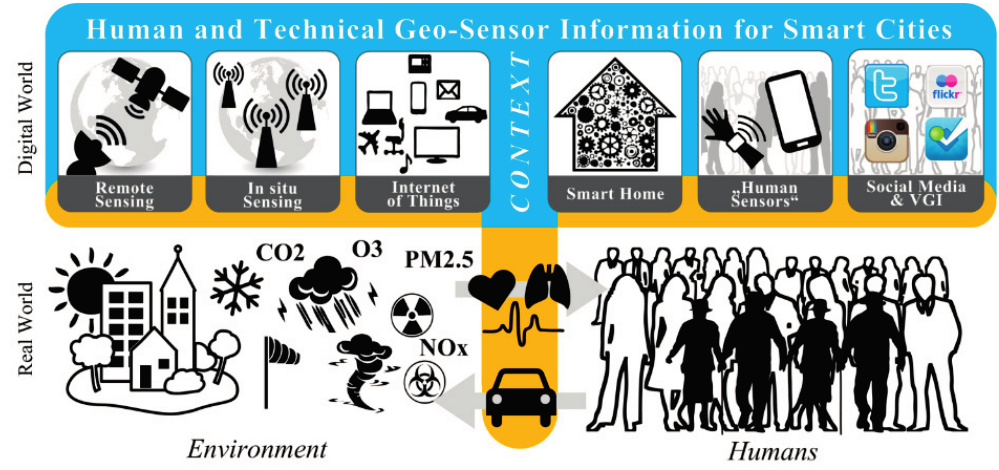
Figure 3. Technology-enabled contextual sensing for smart cities: context-enriched human and technical geo-sensor information for smart cities (note: interaction interfaces between the environment, humans, and technology match those in Figure 1, with emphasis placed on the sensing interface between the real world and the digital